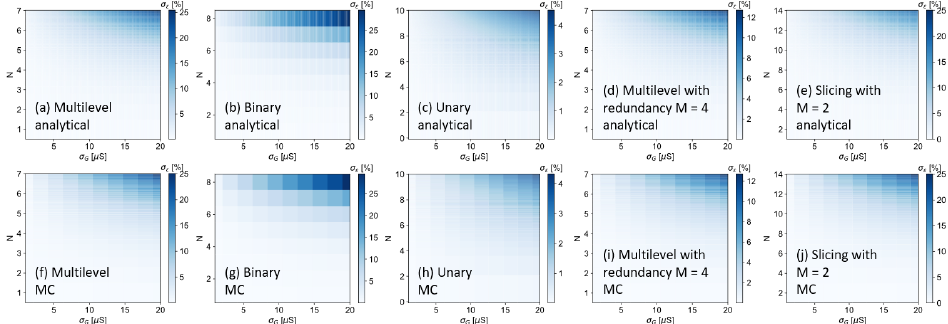
Figure 9. Comparison between analytical formula (top) and MC simulations (bottom) of standard deviation of the programming error σ (cid:101) as a function of the number of bits N and the standard devia- tion of the conductance σ G for multilevel ( a , f ), binary ( b , g ), unary ( c , h ), multilevel with redundancy factor M = 4 ( d , i ) and slicing in M = 2 units ( e , j ). Adapted from